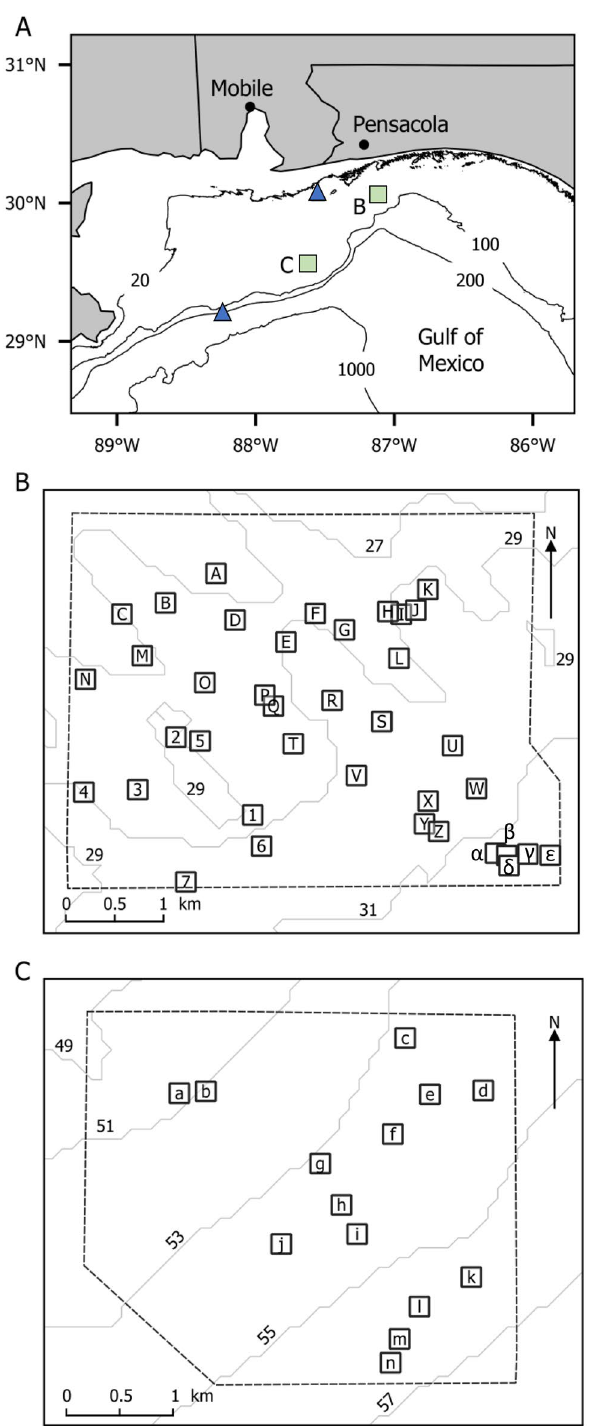
Figure 1. Map of the study area. ( A ) Location of acoustic telemetry arrays (squares) and oceanographic data buoys (triangles) in the northern GOM. Depth contours are labeled in meters. Details are shown for the ( B ) 30-m and ( C ) 55-m acoustic telemetry arrays. The approximate positioning boundaries of each array are noted by a broken line, artificial reefs are noted with labeled squares, and depth contours are labeled in